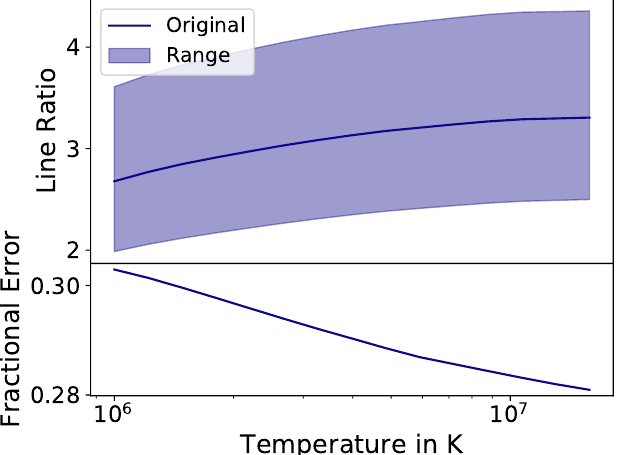
15% uncertainty ± 30% for ∼